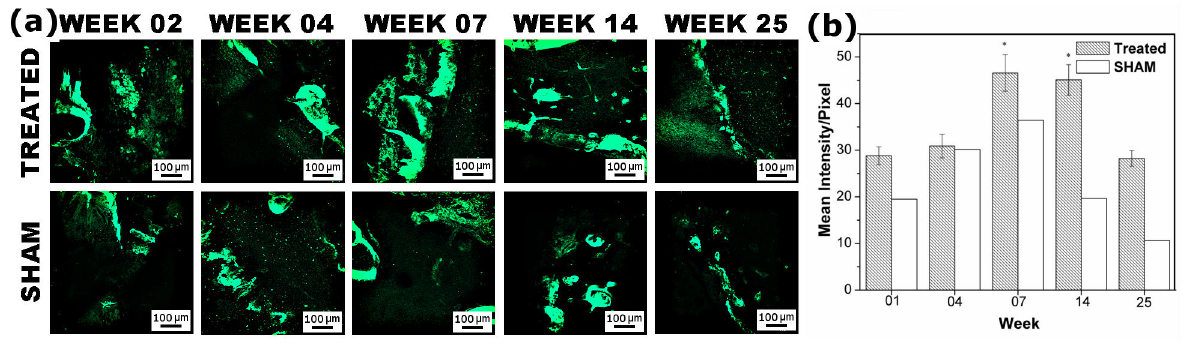
Figure 6. (a) Representative fluorescence images of calcein labeling and (b) graph showing Mean Intensity/Pixel of restored defects treated with n-HA/gel/CMC and SHAM-operated defects. (Scale Bar: 100µm). The absence of significant effect after 14 weeks suggests that most of the healing process was completed and further remodeling overtake new bone formation upto the end of the study. doi: